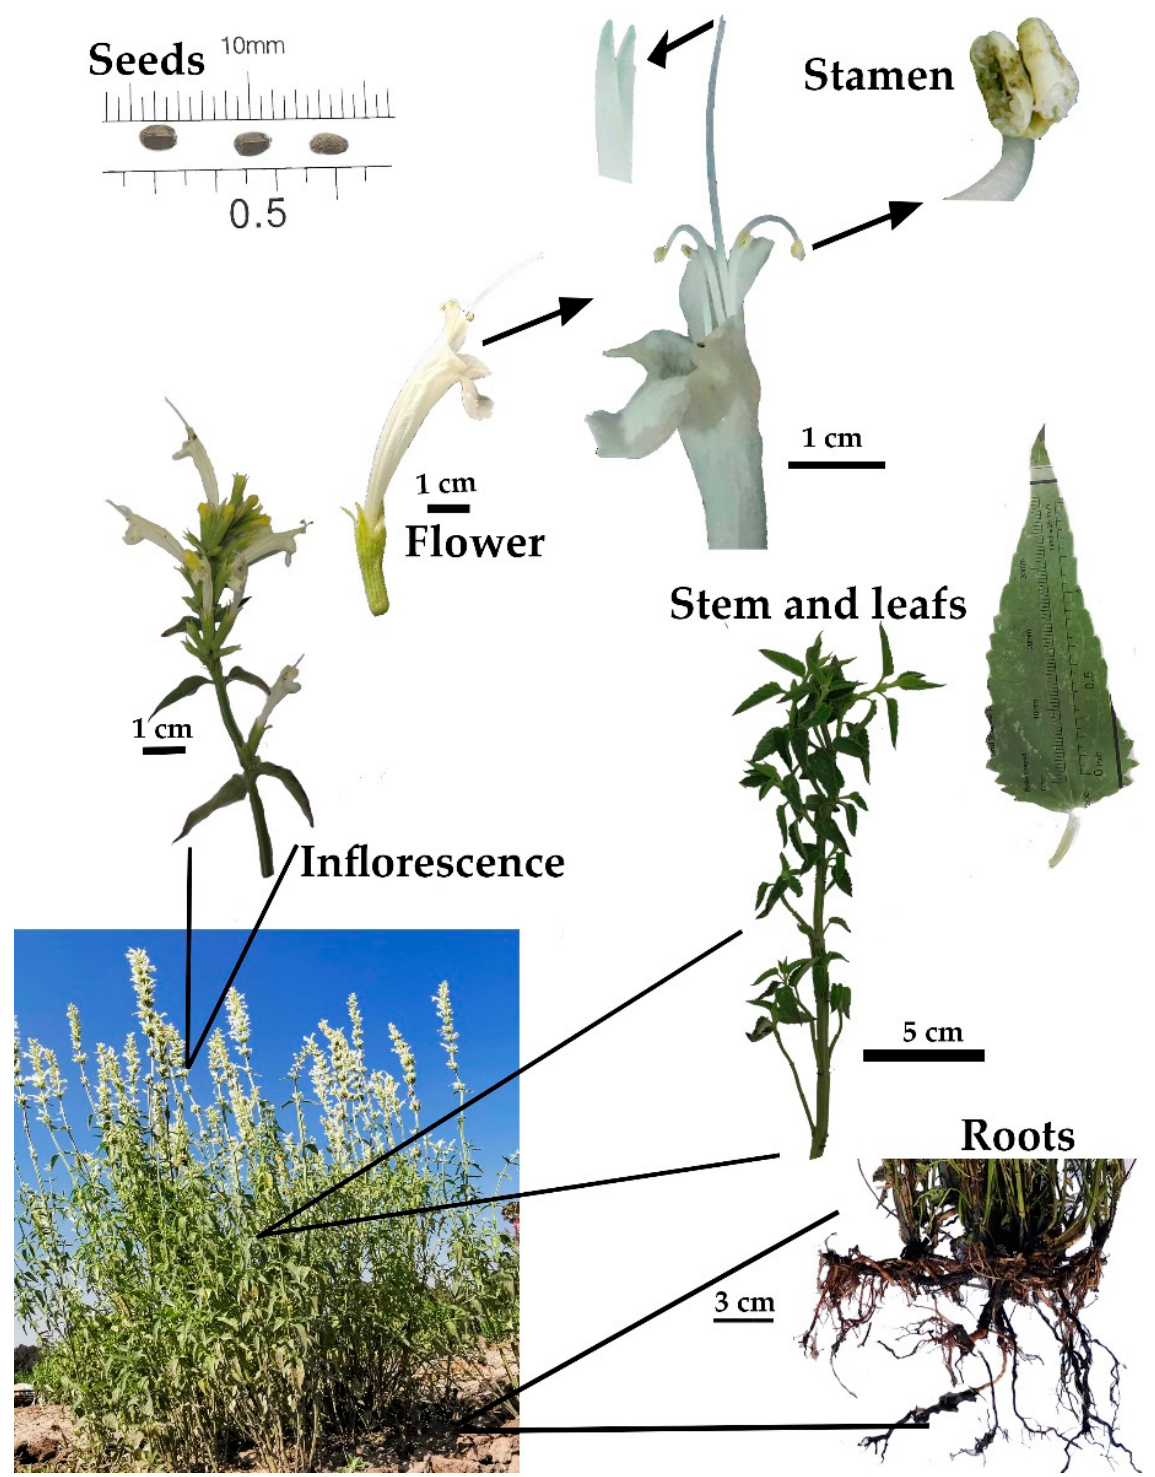
Figure 4. Plant biology of Agastache mexicana ssp. xolocotziana.